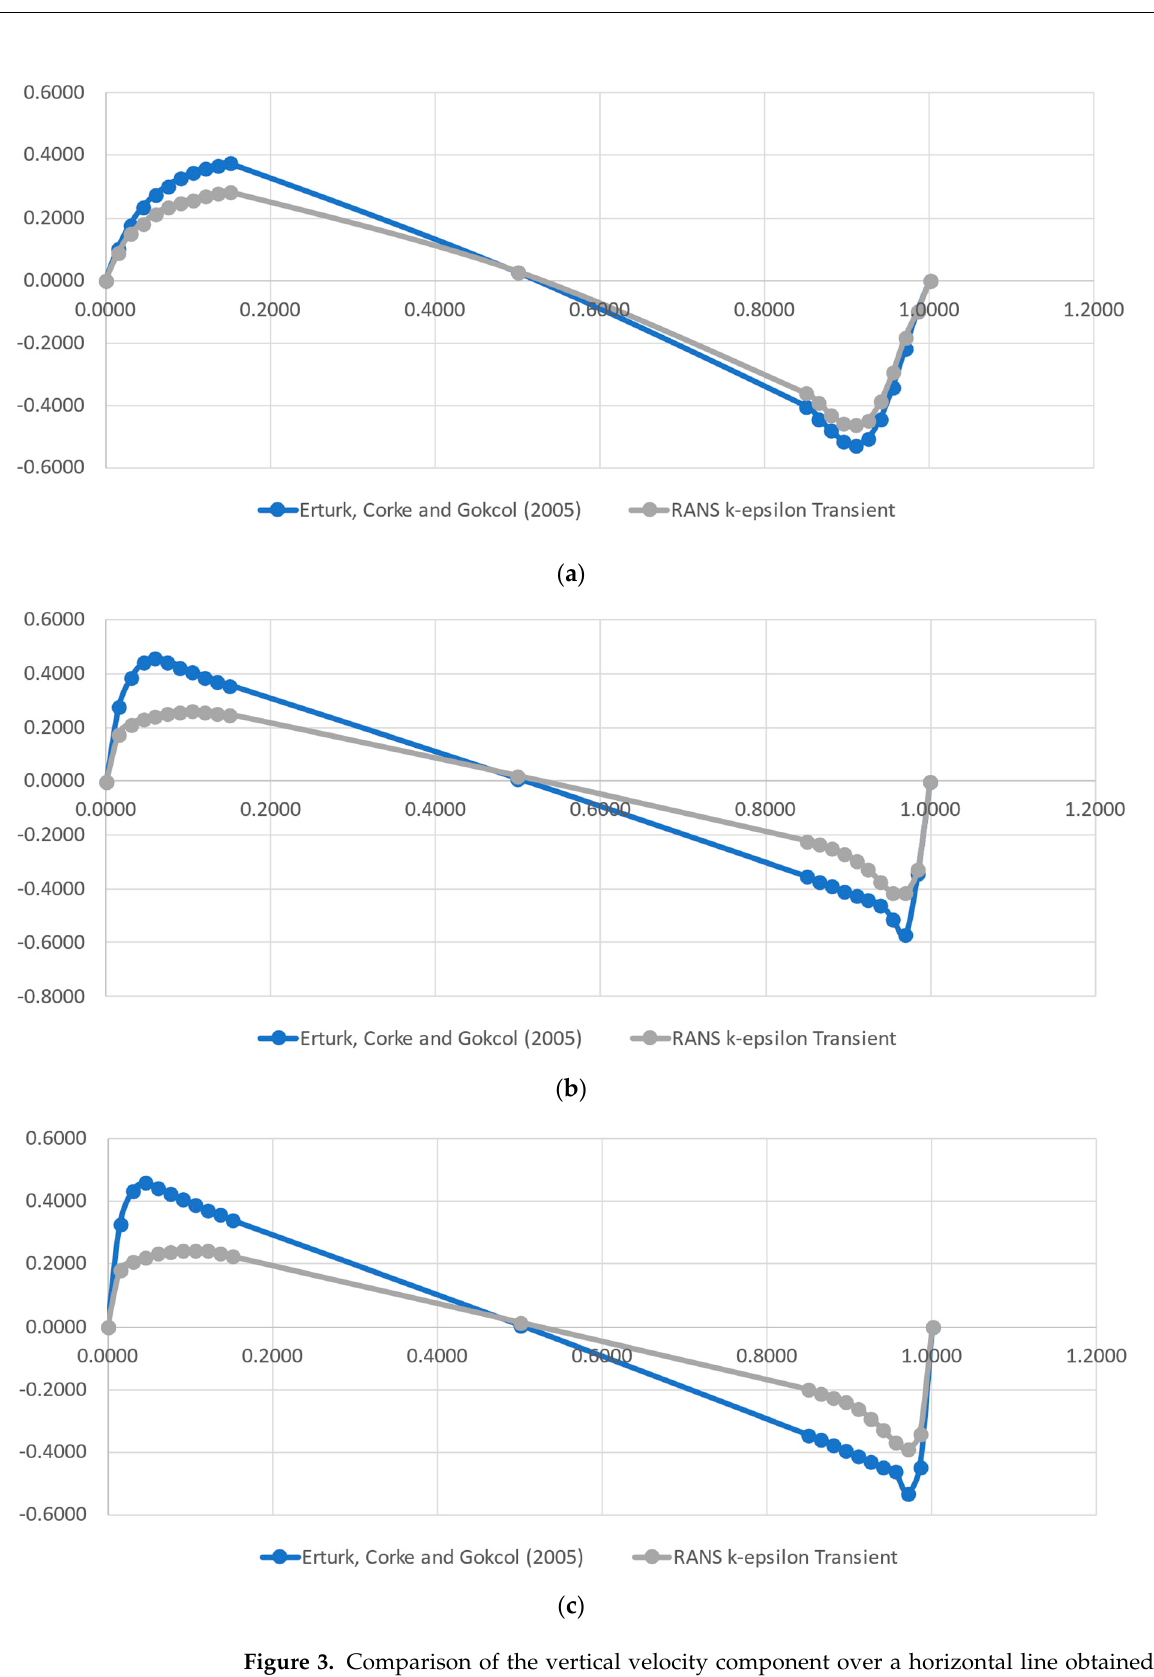
Figure 3. Comparison of the vertical velocity component over a horizontal line obtained by the CFD model and the reference values from [37] for the Reynolds numbers of 1000 ( a ), 10,000 ( b ) and 20,000 ( c ).